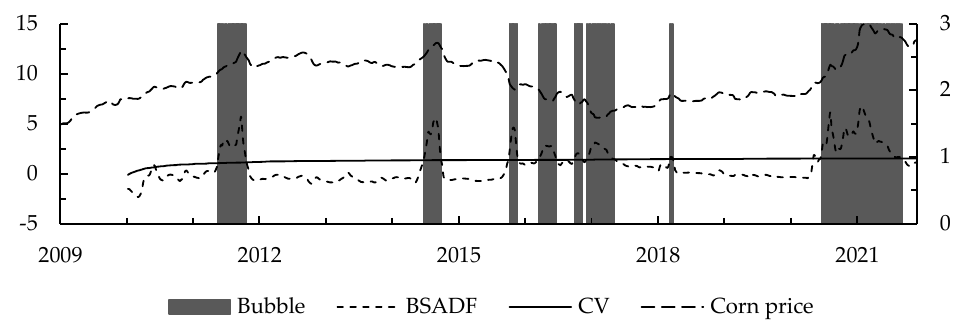
Figure 6. Bubbles in corn prices.